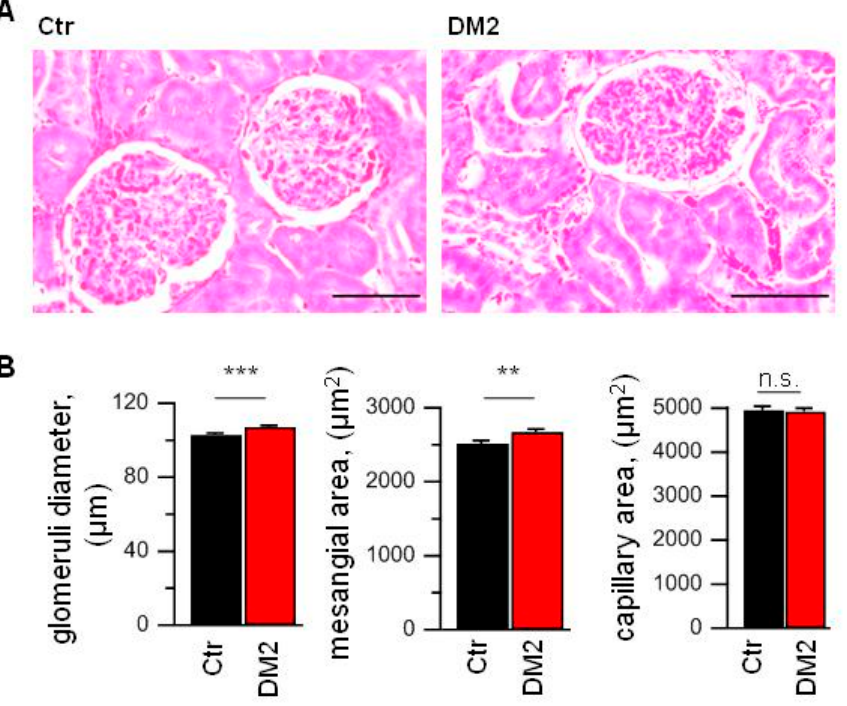
Figure 3. High-fat diet and STZ injection results in the glomerular hypertrophy and mesangial expansion. ( A ) Masson Trichrome stained slices from control (Ctr) and diabetic (DM2) right kidney. Scale bar equal 50 µm. ( B ) The averaged data obtained from analysis of right kidney slices (N = 9 rats per group; n= 450 glomeruli per group). Data were statistically analyzed by Student t -test. n.s., not significant, ** and *** indicate p values of <0.01, and <0.001,